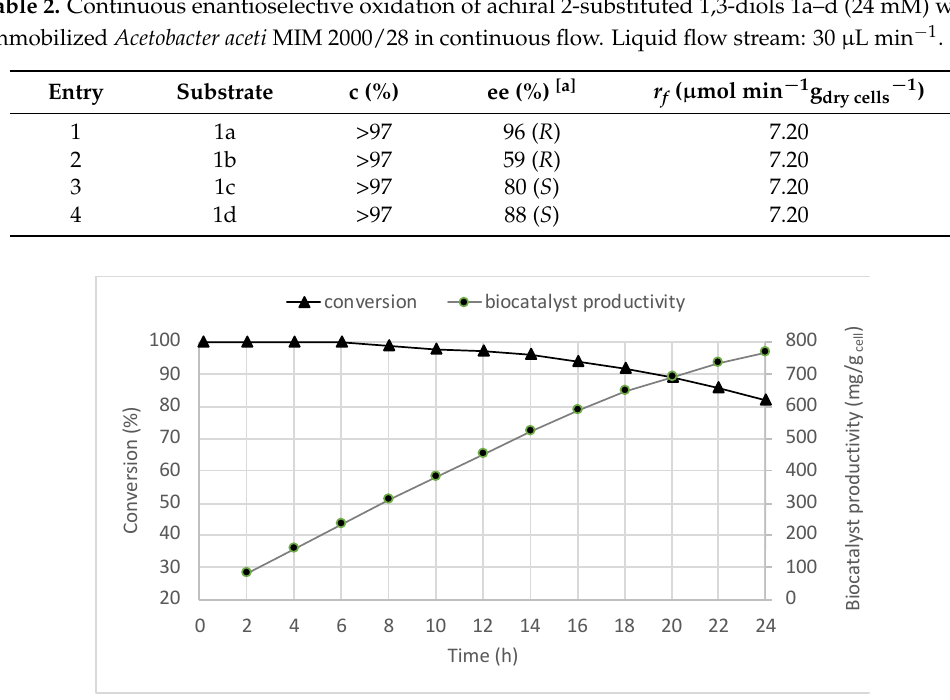
(1) Table 1. Continuous flow enantioselective oxidation of 1a with immobilized Acetobacter aceti MIM 2000/28. entry